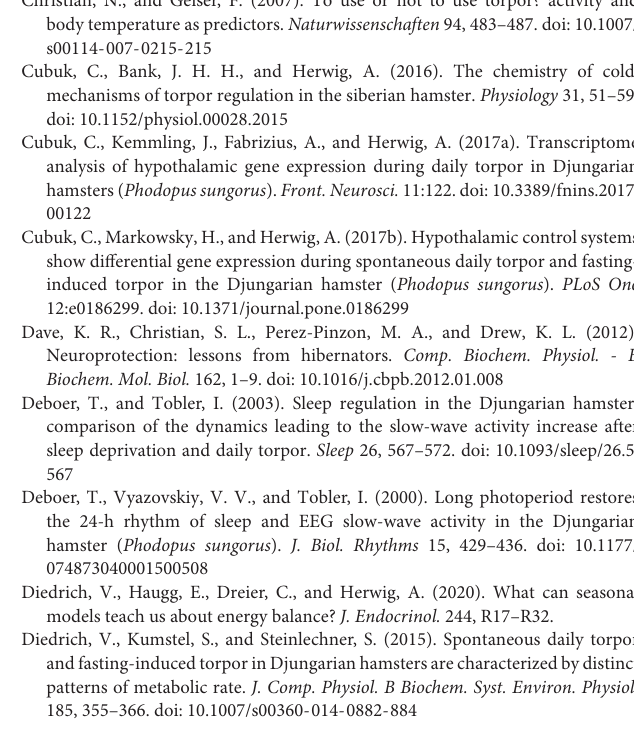
Yellow marked hamsters did not express spontaneous daily torpor. Sparklines in the last column indicate the individual change, with the hamster’s highest value as 100% and its lowest as 0%.